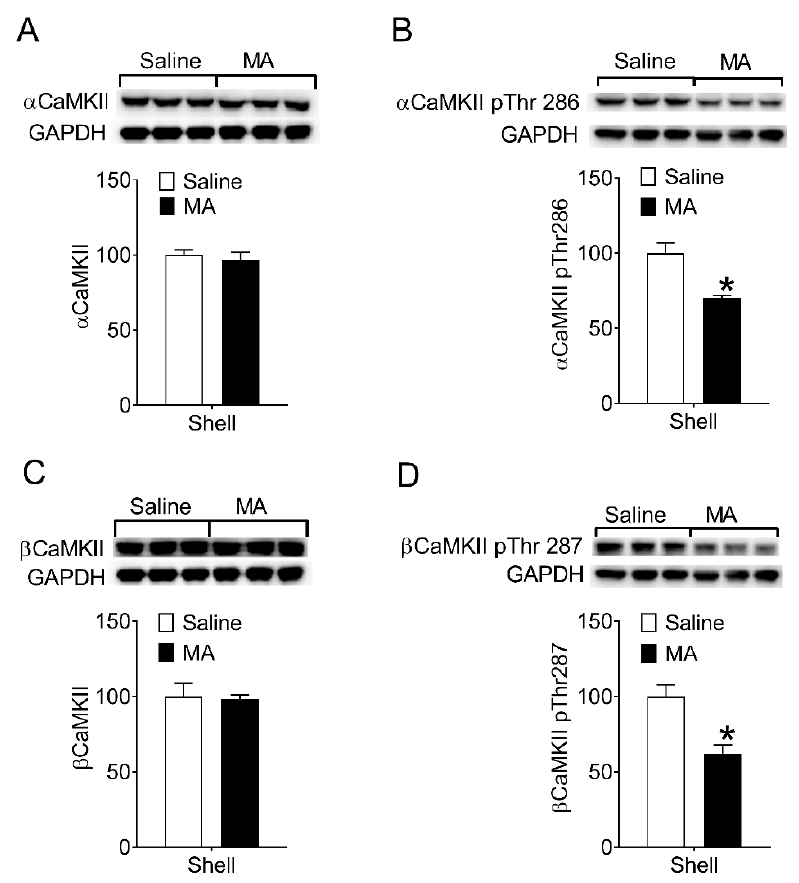
Figure 4. Intravenous injection of MA decreased phosphorylation of CaMKII on Thr286/287 in the NAc shell during the reinstatement. ( A , C ) No significant differences in the levels of total α ( t 4 = 0.56, p = 0.61) and β CaMKII ( t 4 = 0.16, p = 0.88) between saline controls ( n = 3) and MA group ( n = 3). ( B ) The levels of α CaMKII phosphorylated on Thr286 in the NAc shell were lower in the MA group than that in the saline controls during the reinstatement ( t 4 = 4.23, p < 0.02). ( D ) The levels of β CaMKII phosphorylated on Thr287 in the NAc shell were lower in the MA group than that in the saline controls during the reinstatement ( t 4 = 3.84, p < 0.02). Asterisks indicate a significant difference (* p < 0.05) between saline controls and MA group. Data are expressed as mean ± SEM.